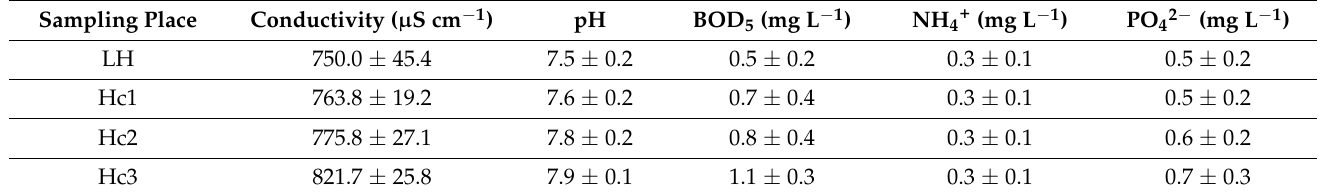
Table 2. The conductivity, pH, BOD 5 , NH 4+ and PO 42 − concentration values of the four sampling points in the studied period. Sampling Place